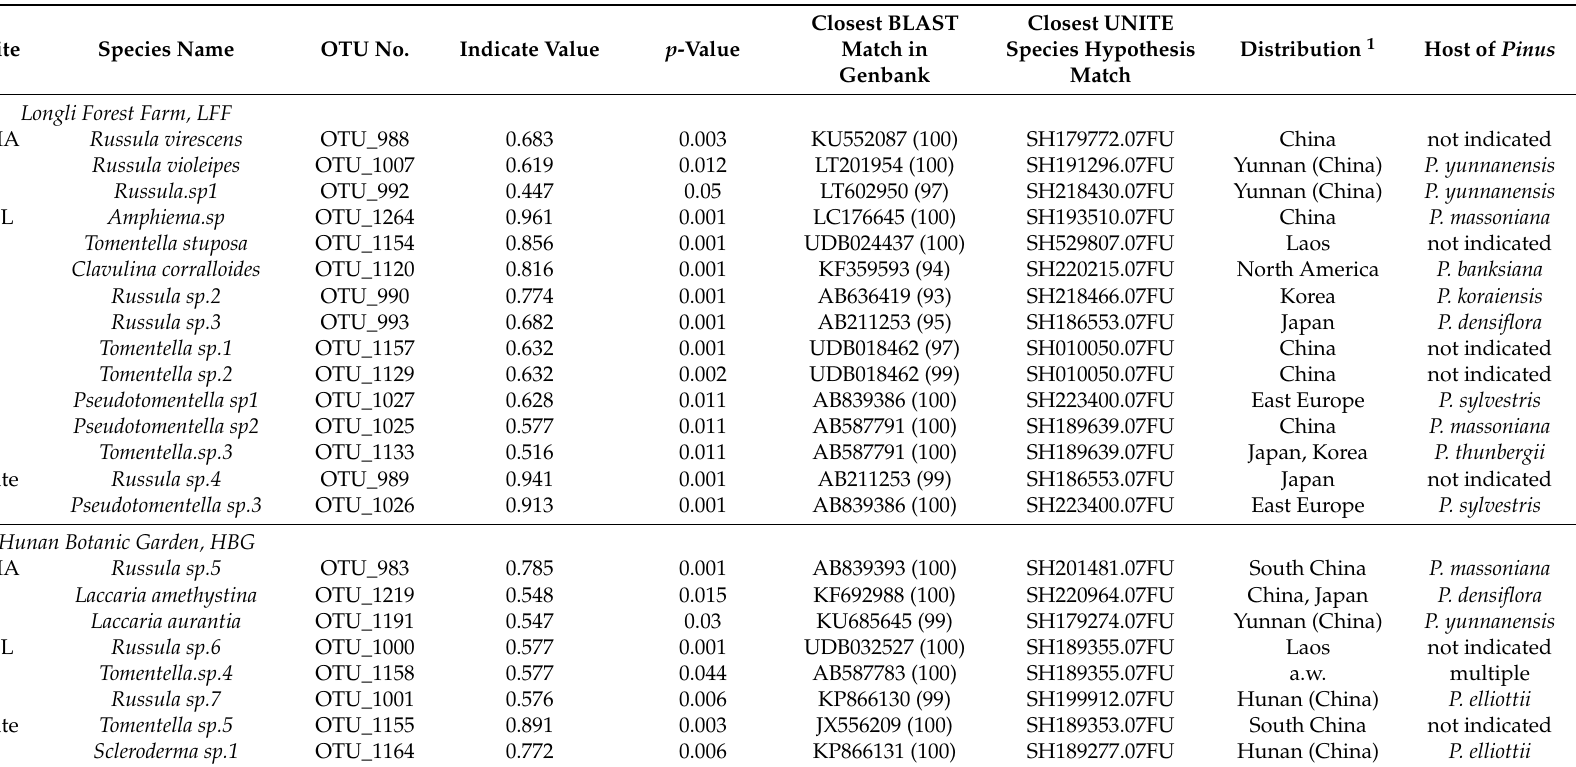
Table 1. Indicator species analyses. The table shows the number of ectomycorrhizal (ECM) fungal molecular taxa (OTU) significantly associated with each habitat type, their indicator species value [52] and associated probability. Based on species hypotheses, the distribution area and possible host species was assigned by closest similar representative sequence data in UNITE. MA-masson pine, SL-slash